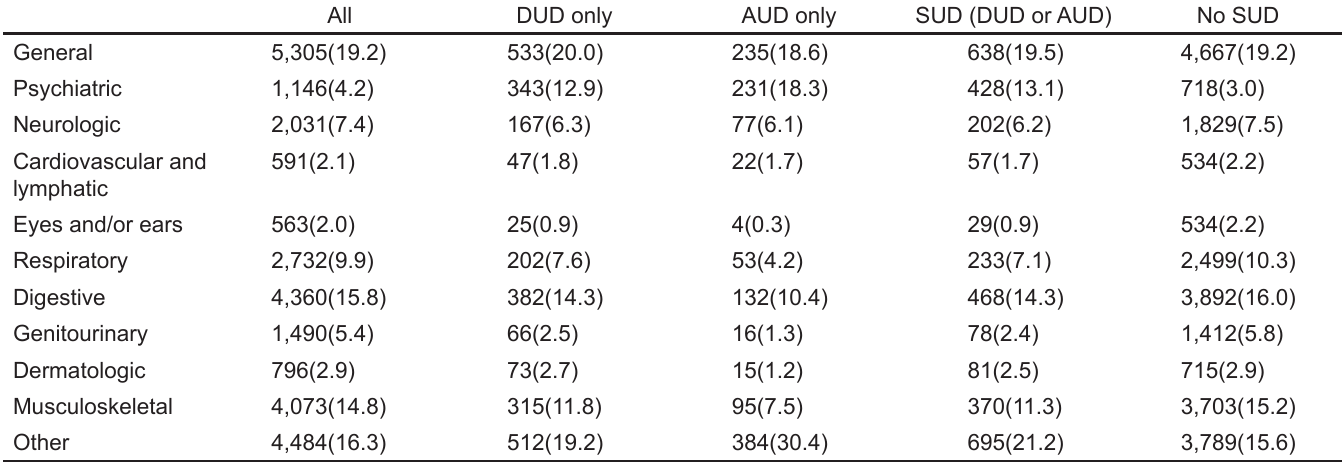
Table 2. Selected reason for visit and emergency department diagnosis among patients with drugs/alcohol substance use disorder, *NHAMCS